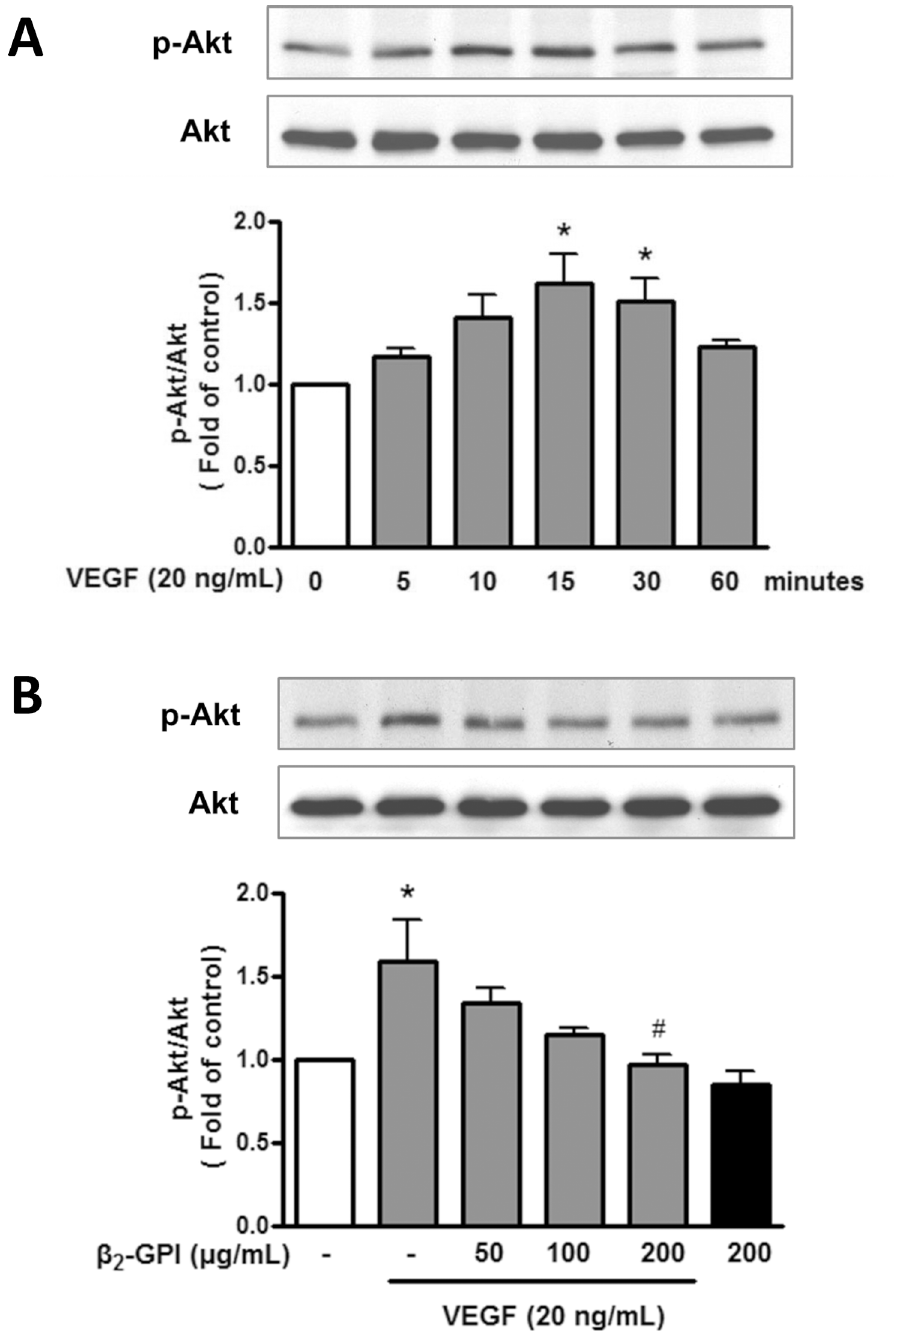
Fig 5. β 2 -GPI inhibits the VEGF-induced Akt phosphorylation in HAECs. (A) A time course of Akt phosphorylation in HAECs treated with VEGF was determined by Western blot analysis. The intensity of the Akt phosphorylation band was normalized against total Akt expression and was calculated as an expression fold (relative to the control, which was set as 1). (B) The effect of β 2 -GPI on VEGF-induced Akt phosphorylation was determined in HAECs treated with or without VEGF in combination with β 2 -GPI at indicated concentrations. Results are presented as mean ± SEM and representative of more than three independent experiments. * p < 0.05 versus control; # p < 0.05 versus VEGF treatment